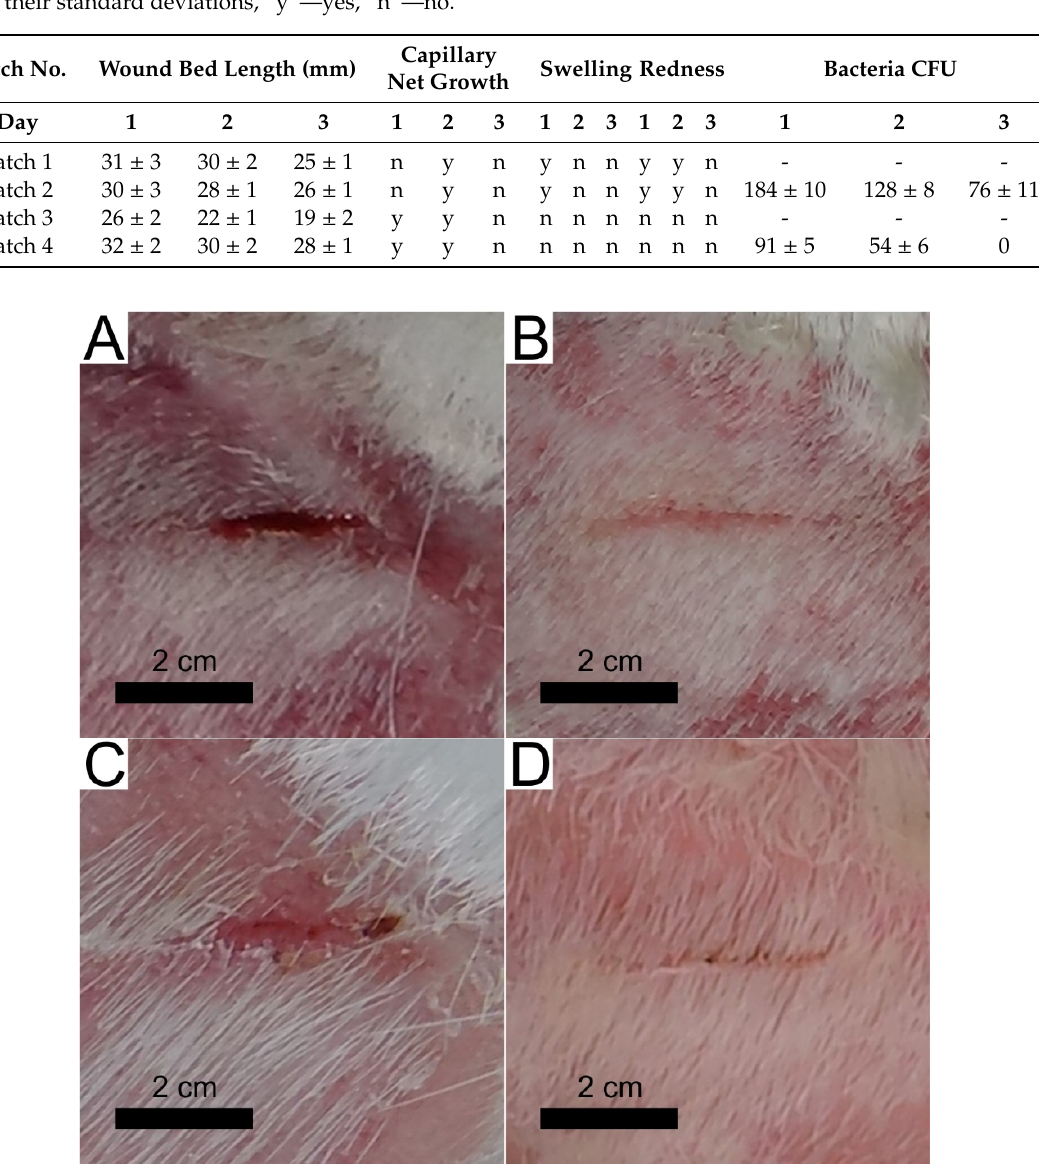
Table 1. The wound-healing observation: 1—control patch on the uninfected wound; 2—control on methicillin-resistant S. aureus (MRSA)-infected wound, 3—patch prototype on uninfected wound. 4—patch prototype applied on MRSA-infected wound. Numbers represent the values together with